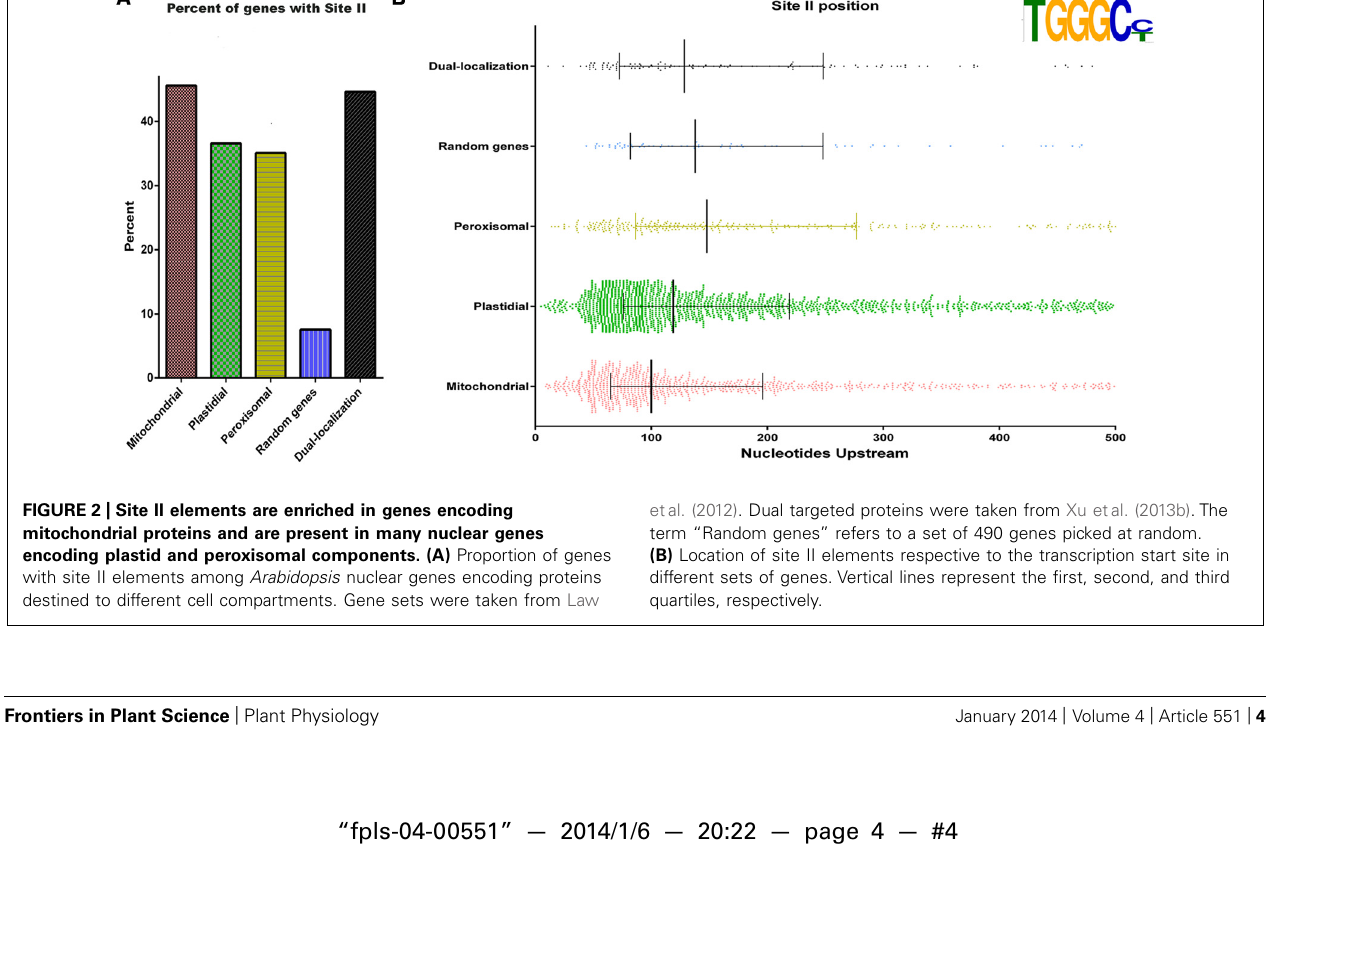
FIGURE 2 | Site II elements are enriched in genes encoding mitochondrial proteins and are present in many nuclear genes encoding plastid and peroxisomal components. (A) Proportion of genes with site II elements among Arabidopsis nuclear genes encoding proteins destined to different cell compartments. Gene sets were taken from Law